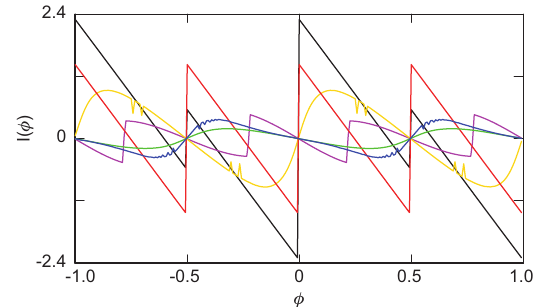
Figure 15 Persistent current as a function of fl ux φ for a half-fi lled mesoscopic cylinder taking N = 15 and M = 2 in the presence of NNH and SNH integrals. The black line corresponds to the ordered case when U = 0, whereas the magenta and gold lines correspond to the disordered case ( W = 2) when U = 0 and 1.5, respectively. Here, SNH integral is fi xed at -0.6. The currents shown by the red, green, and blue lines for the ring described with NNH model (identical to Figure 14) are re-plotted to judge the effect of SNH integral over NNH model much